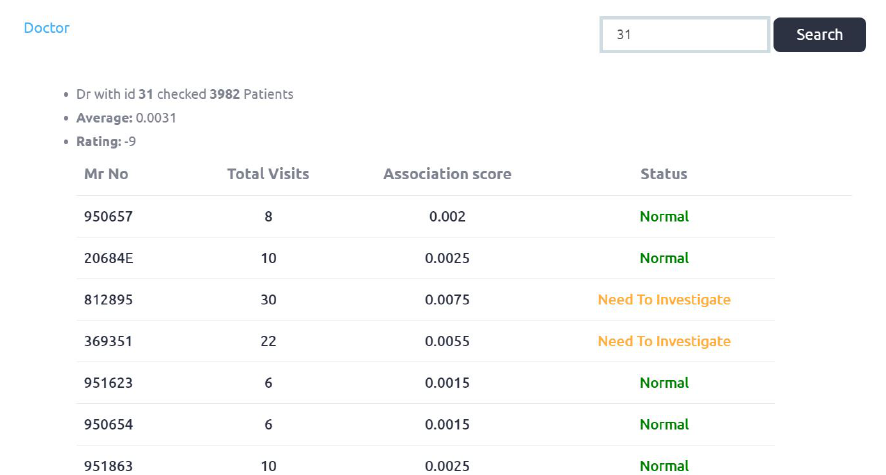
Figure 16. Doctor_id 31 initial rating in First